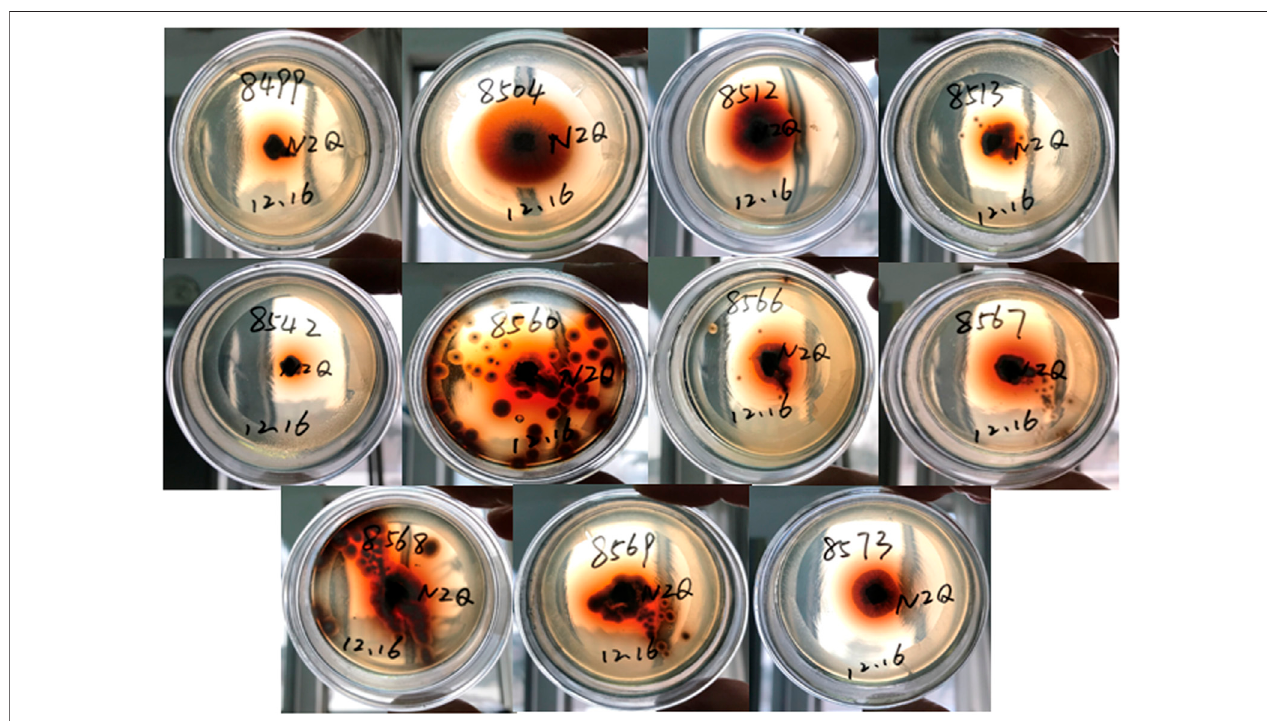
FIGURE 2 | Screening of β -glucosidase-producing endophytic fungi in Esculin-R2A agar.